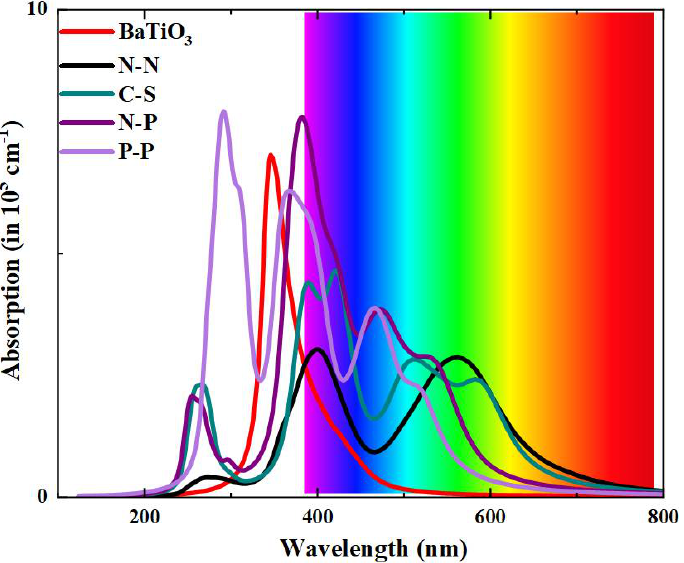
Figure 4. Calculated optical absorption spectra for pristine and anionic-anionic co-doped BaTiO 3 at the HSE06 level.